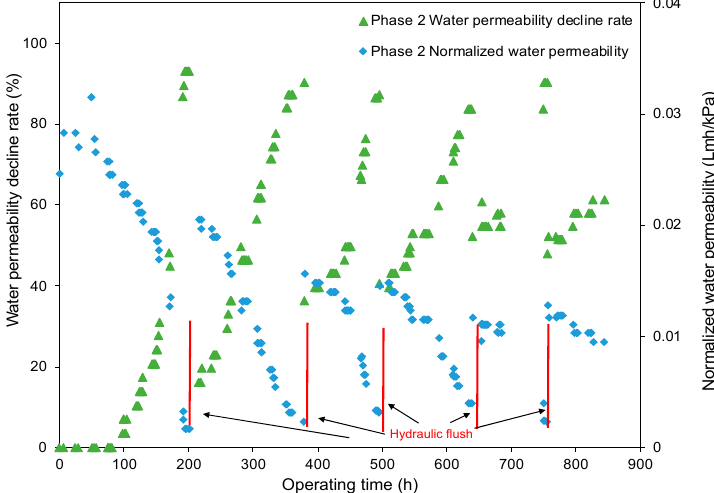
Figure 4. Normalized water permeability and decline rate during Phase 1 testing.